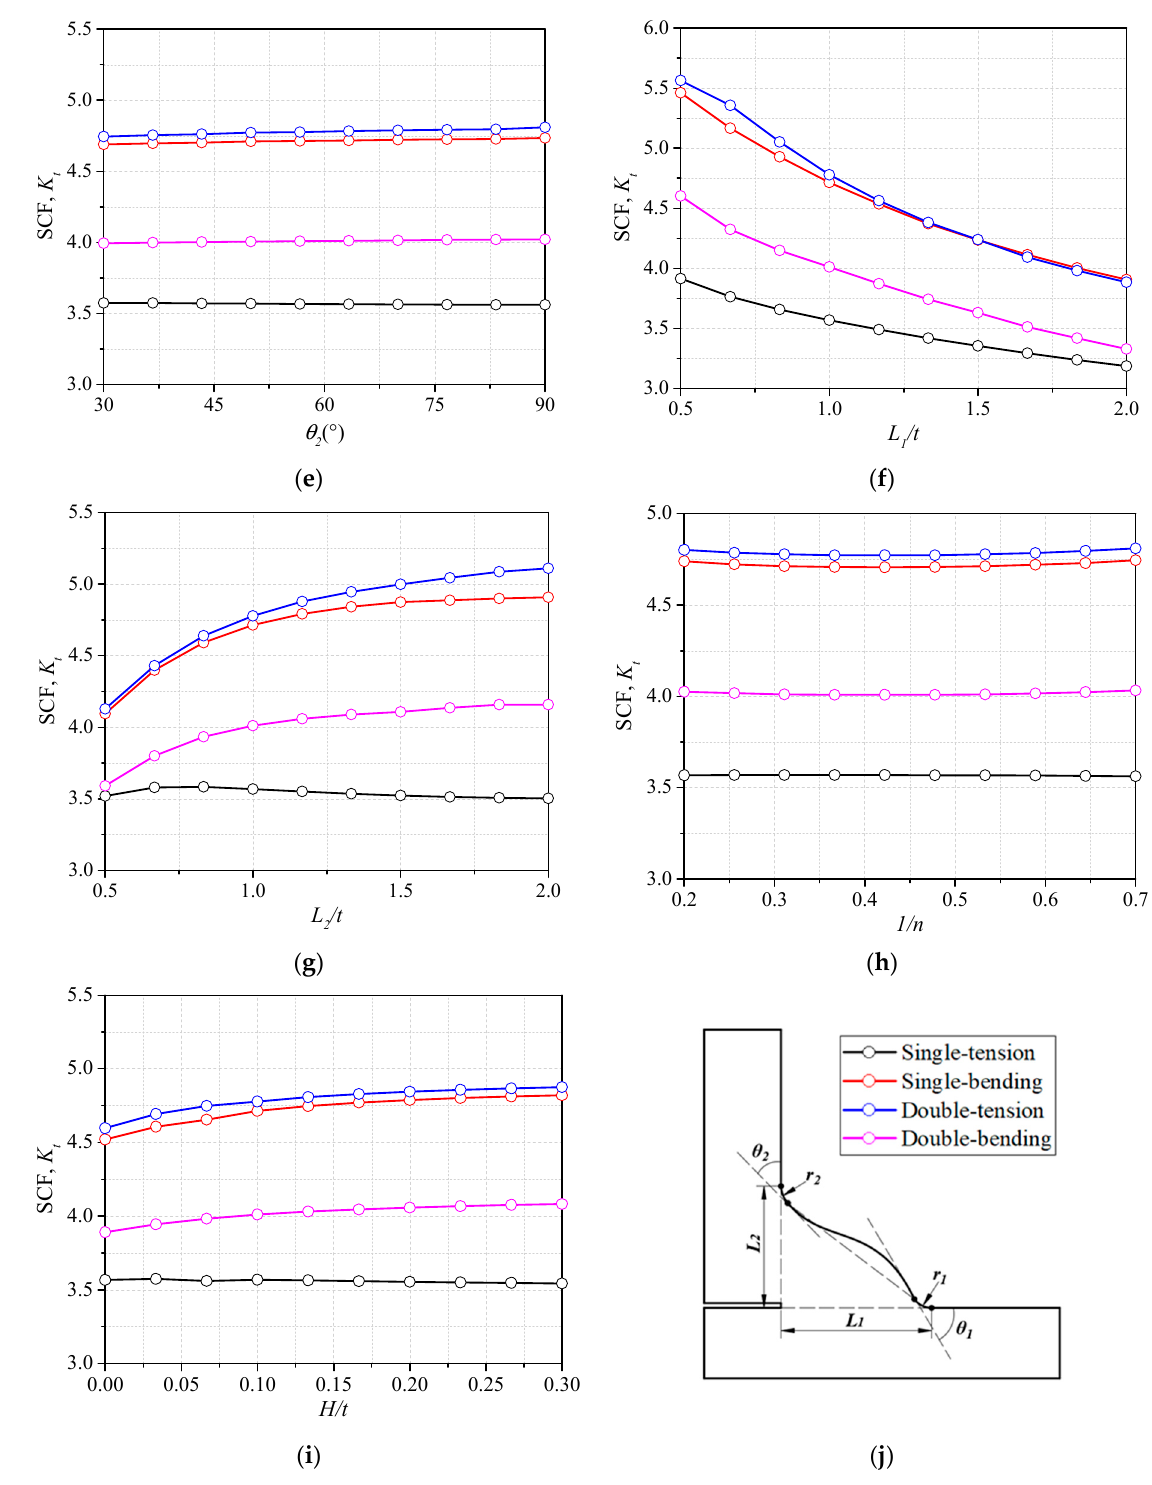
Figure 6. Influence of the weld geometry: ( a ) T/t ; ( b ) r 1 /t ; ( c ) θ 1 ; ( d ) r 2 /t ; ( e ) θ 2 ; ( f ) L 1 /t ; ( g ) L 2 /t ; ( h ) 1/n ; ( i ) H/t ; ( j ) the geometry of weld.